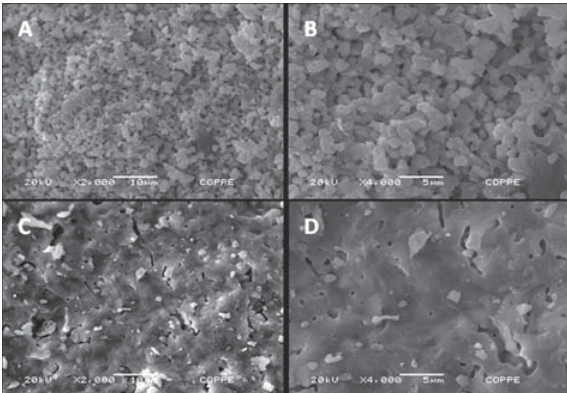
Figure 2- Scanning electron microscopy (SEM) images of tricalcium phosphate granules (250-500 μ m): β -TCP (A;B) and magnesium-substituted β -TCP ( β -TCMP) (C;D)